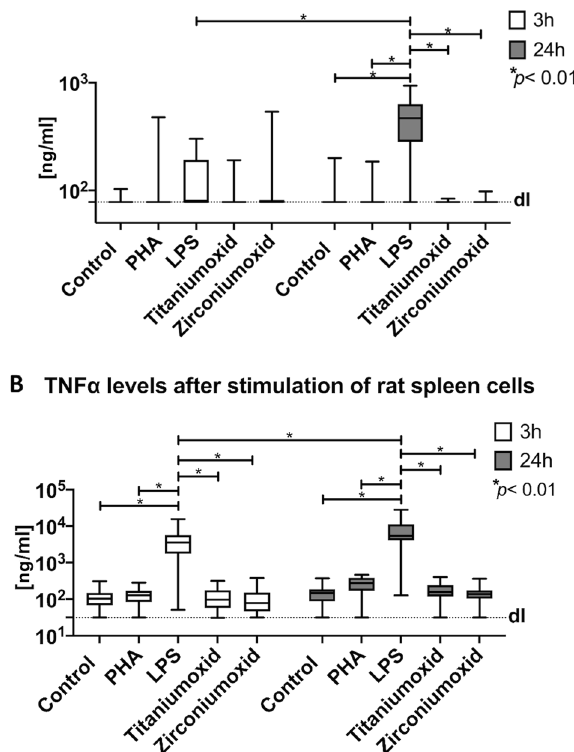
Figure 5. The stimulation levels of the rat spleen cells for interleukin-6 and TNFα were shown for phytohemagglutinine (PHA), lipopolysaccharide (LPS), titaniumoxid-nanopowder and zirconiumoxide nanopowder in relation to a control group. Stimulation levels were assessed after 3 and 24 h. The lowest standard parameter (detection limit) was assessed for IL-6 at 0.078 ng/ml and for TNFα at 0.031